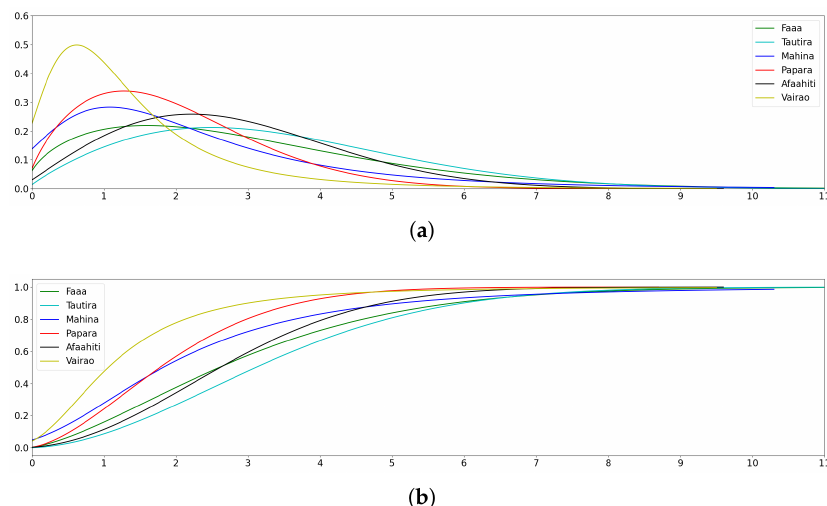
Figure 5. Weibull PDFs and CDFs corresponding to the distribution of wind speed at each location.